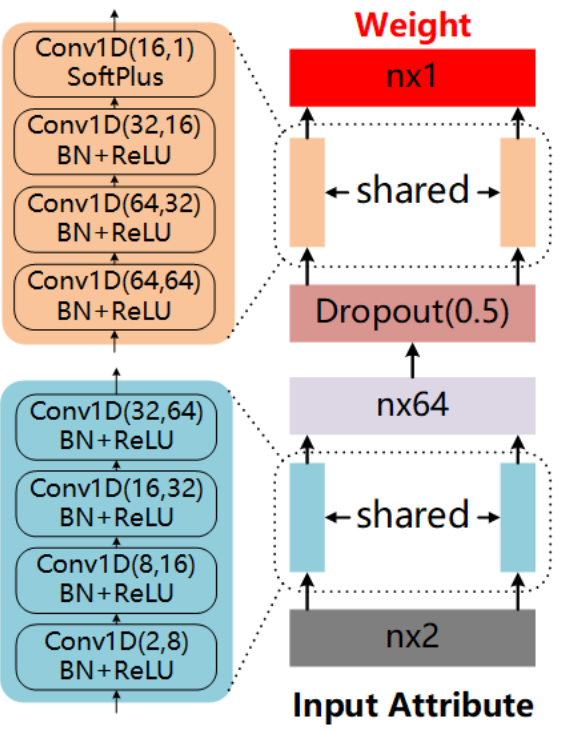
Figure 4. Parameters of our